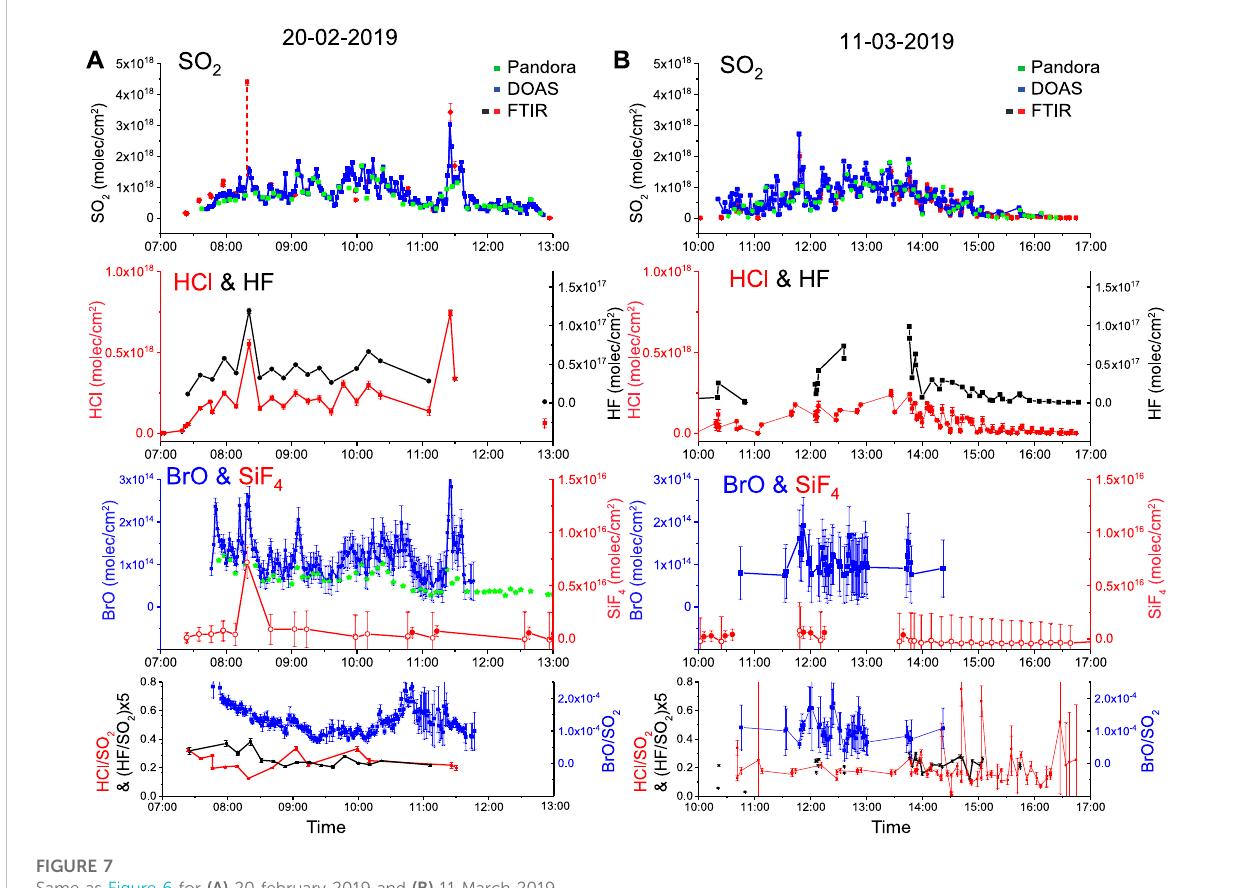
FIGURE 7 Same as Figure 6 for (A) 20 february 2019 and (B) 11 March